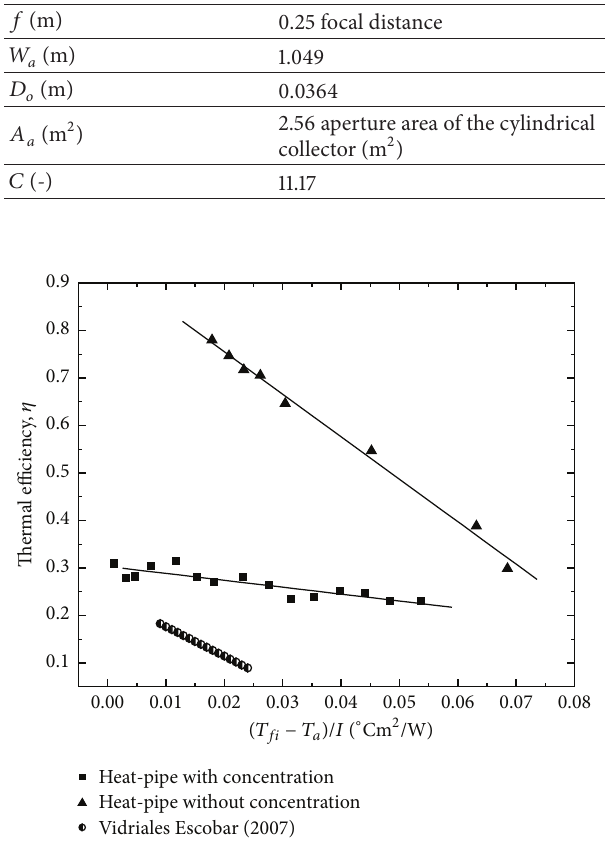
Figure 6: Thermal efficiency data for heat-pipe with concentration and heat-pipe without concentration and Vidriales Escobar